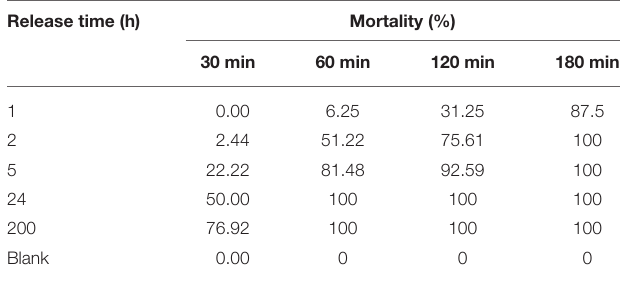
TABLE 1 | The mortality rate of Schistosoma japonicum cercariae for the hydrogel release system N , N ′ -diaspartic acid-3,4,9,10-tetracarboxylic diimide–niclosamide derivative-loaded gel (25 ◦